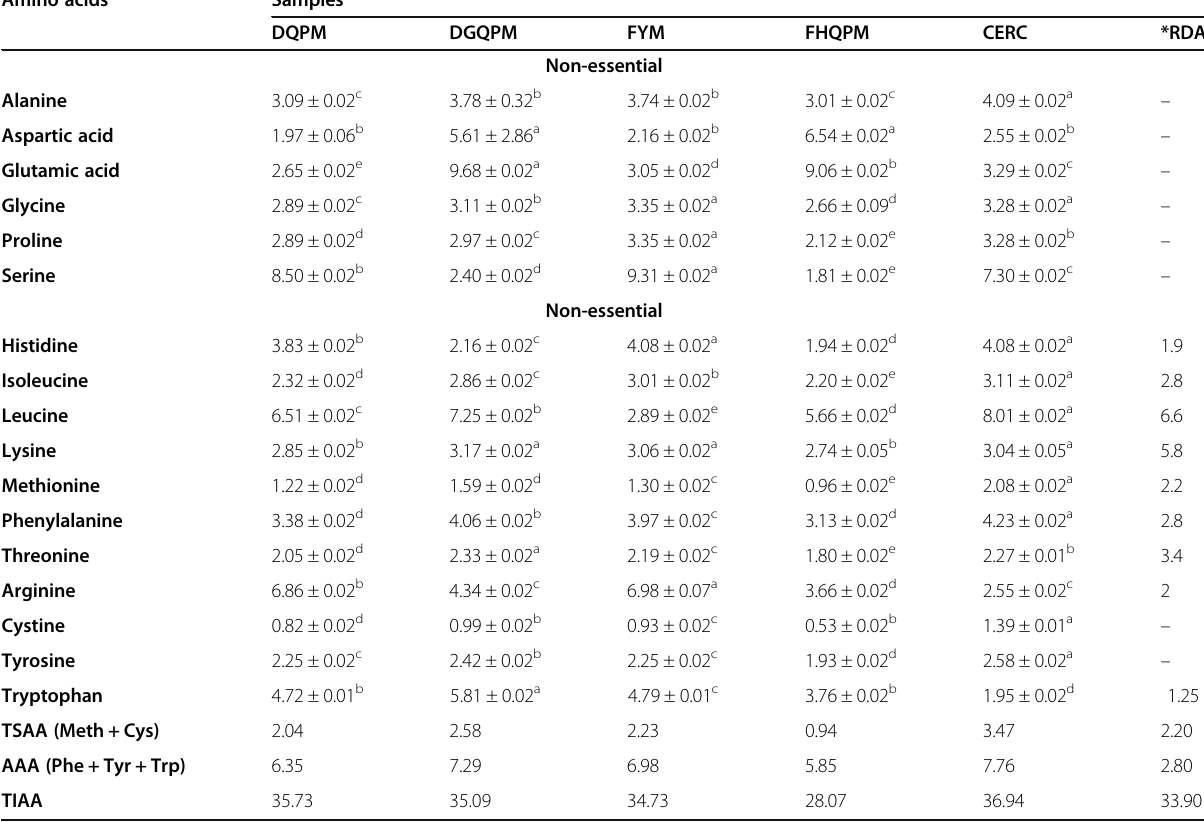
Table 2 Amino acid compositions (g/100 g) of blend of maize and almond seed flours Amino acids Samples